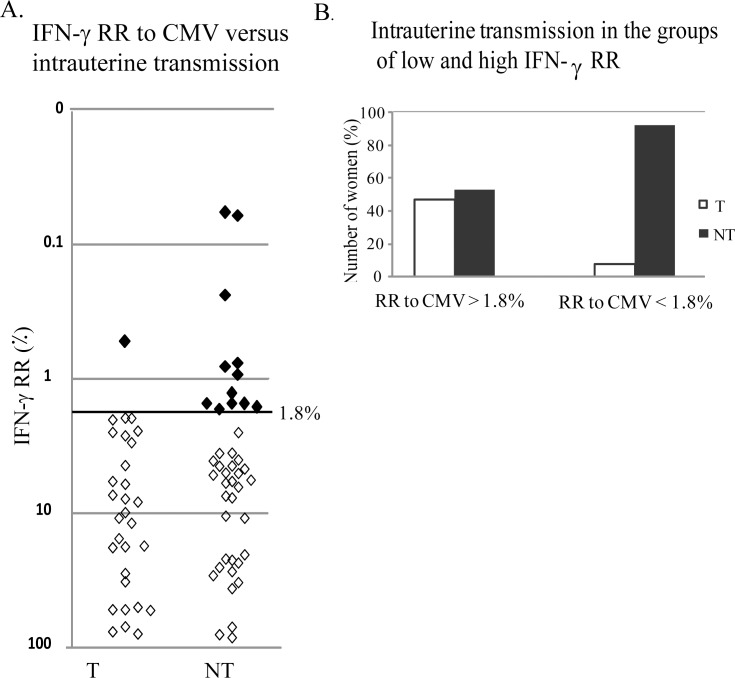
IFN-γ relative response (CMV/M) to CMV and maternal-fetal transmission.A. IFN-γ RR to CMV versus transmission in a continuous distribution, show the individual values. Empty diamonds = high RR, Filled diamonds = low RR. B. Dichotomic distribution of transmitters and non transmitters among women with low (<1.8%) and high (>1.8%) IFN-γ RR, suggesting potential clinical application. IFN-γ RR>1.8%: 29/30 transmitters and 33/45 non-transmitters. IFN-γ RR<1.8%: 1/30 transmitters and 12/45 non-transmitters. RR = relative response, T = transmitters, NT = non transmitters.